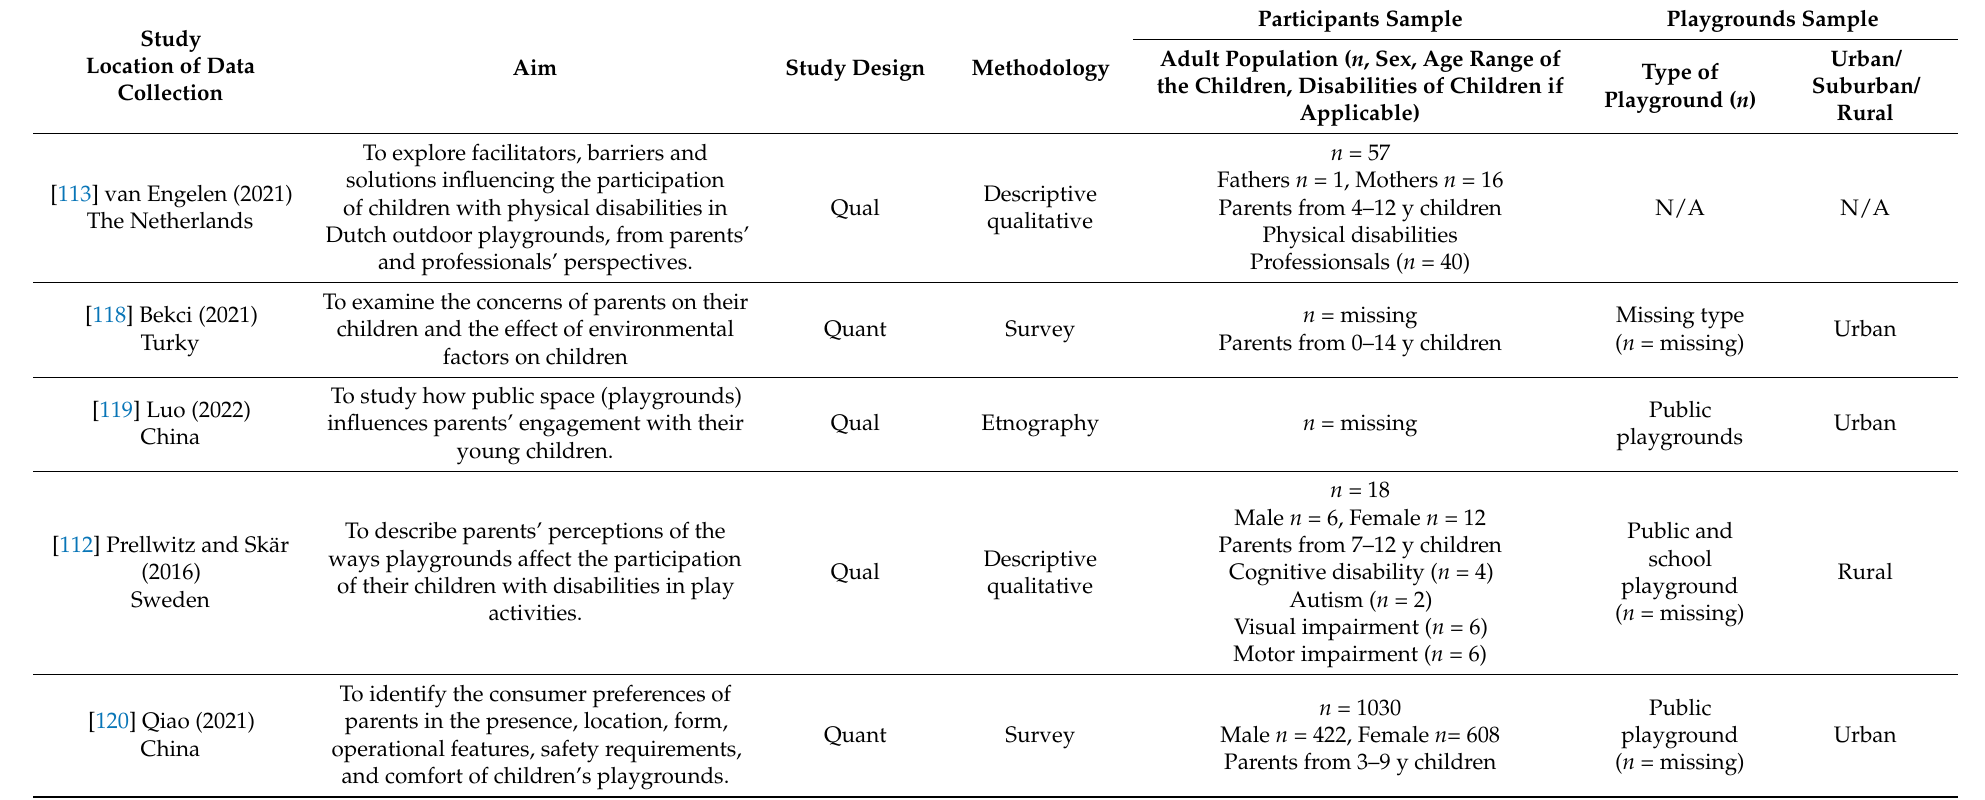
Table A1. Studies on parents’ perspectives excluded from the review: aims, characteristics, participants, and playgrounds